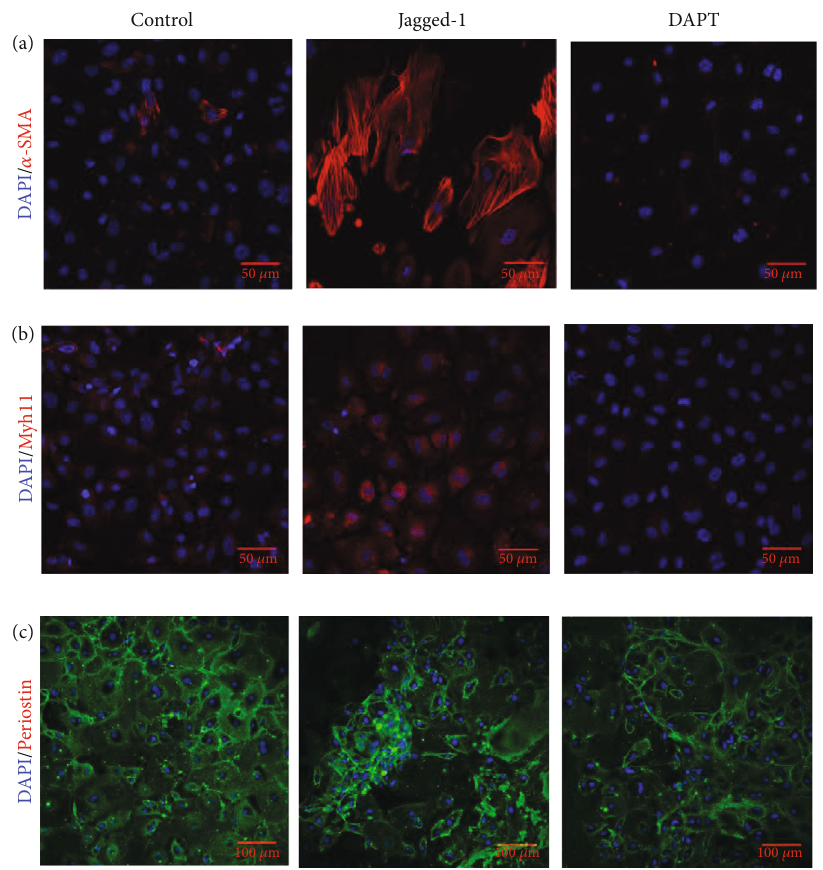
Figure 7: DAPT treatment reduced the di ff erentiation of EPCs into smooth muscle cells. (a, b) Jagged-1 treatment increased the expression of smooth muscle cell speci fi c marker α -SMA and Myh11, while DAPT reduced their expression. (c) Jagged-1 and DAPT treatment did not a ff ect the expression of fi broblast speci fi c marker